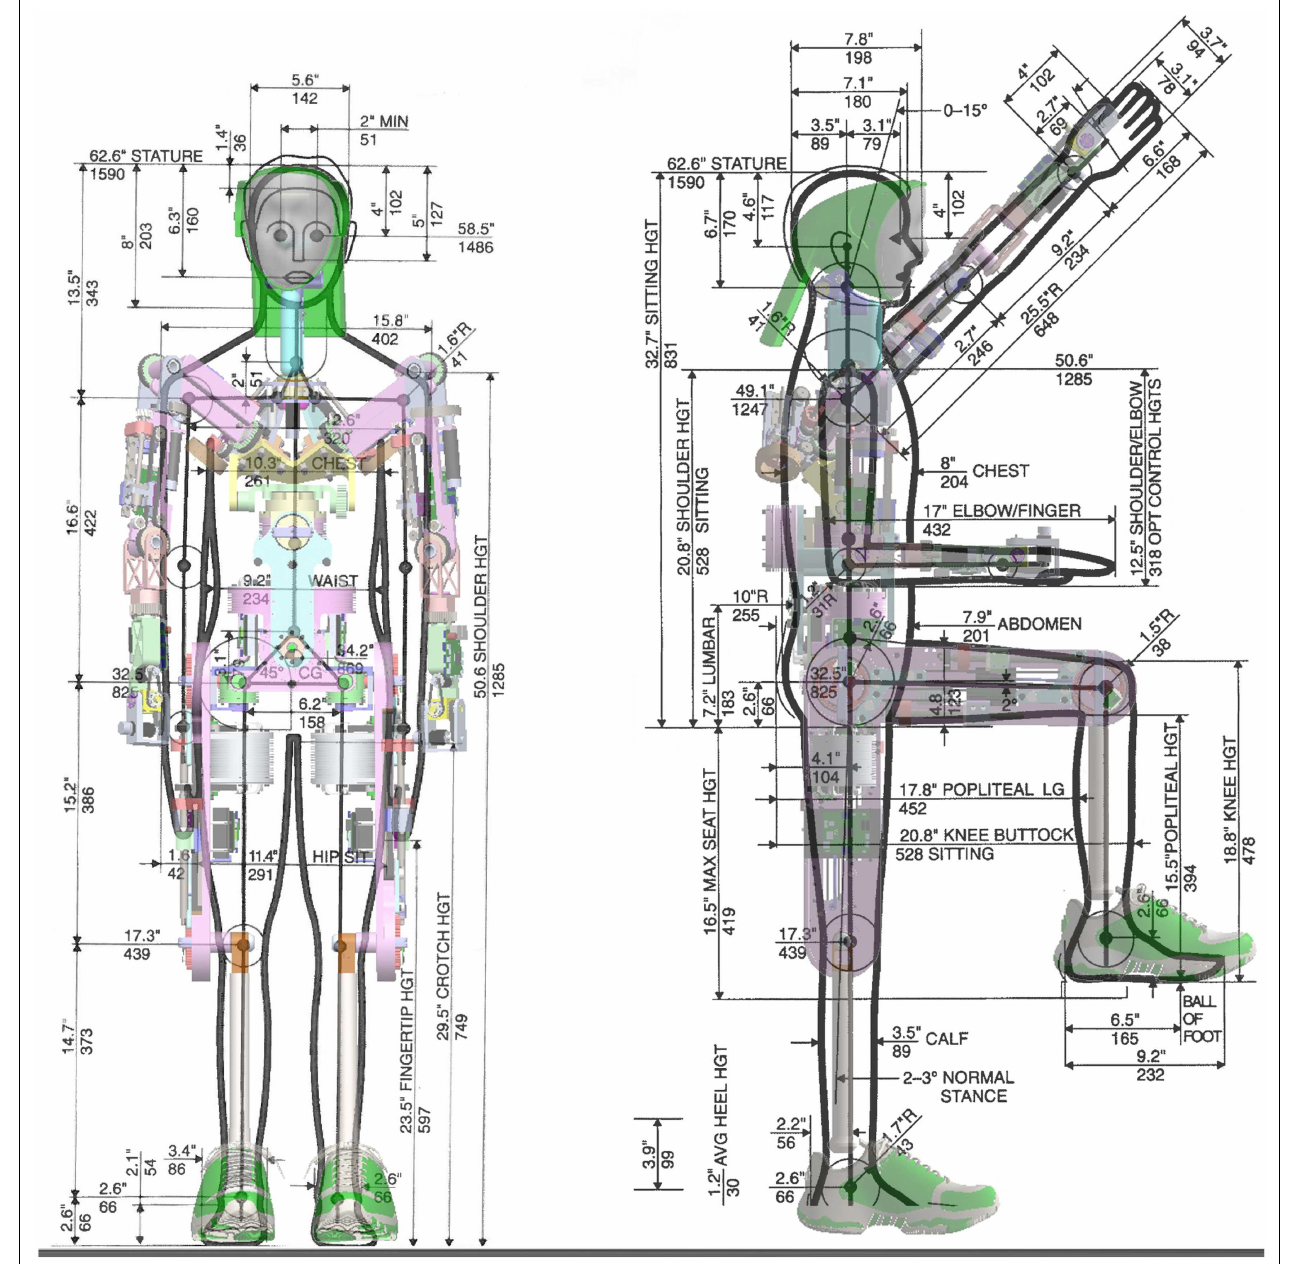
FIGURE 2 | The human proportion of Herbert: all the major joints are in their anthropometrically correct position, we used a 1 percentile full size human man .